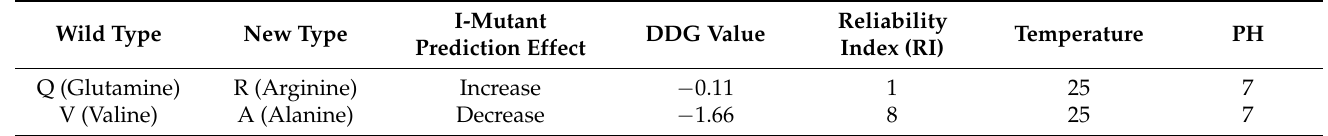
Table 12. OprM gene Prediction results of I-Mutant software.